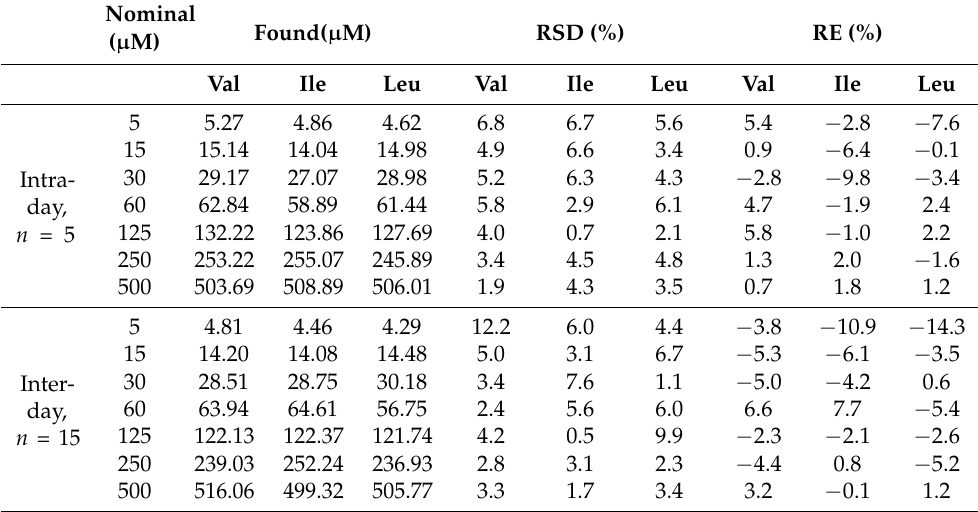
Table 7. Accuracy and precision of the CE-MS method investigated according to the ICH Q2(R1)